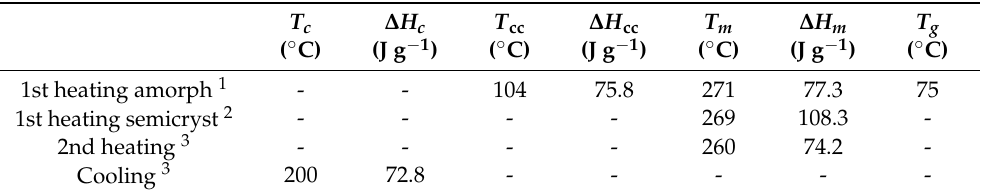
Table 1. Calorimetric data obtained from Differential Scanning Calorimetry (DSC) scans at 10 ◦ C min − 1 . The enthalpies have been normalized by the weight fraction of the samples.